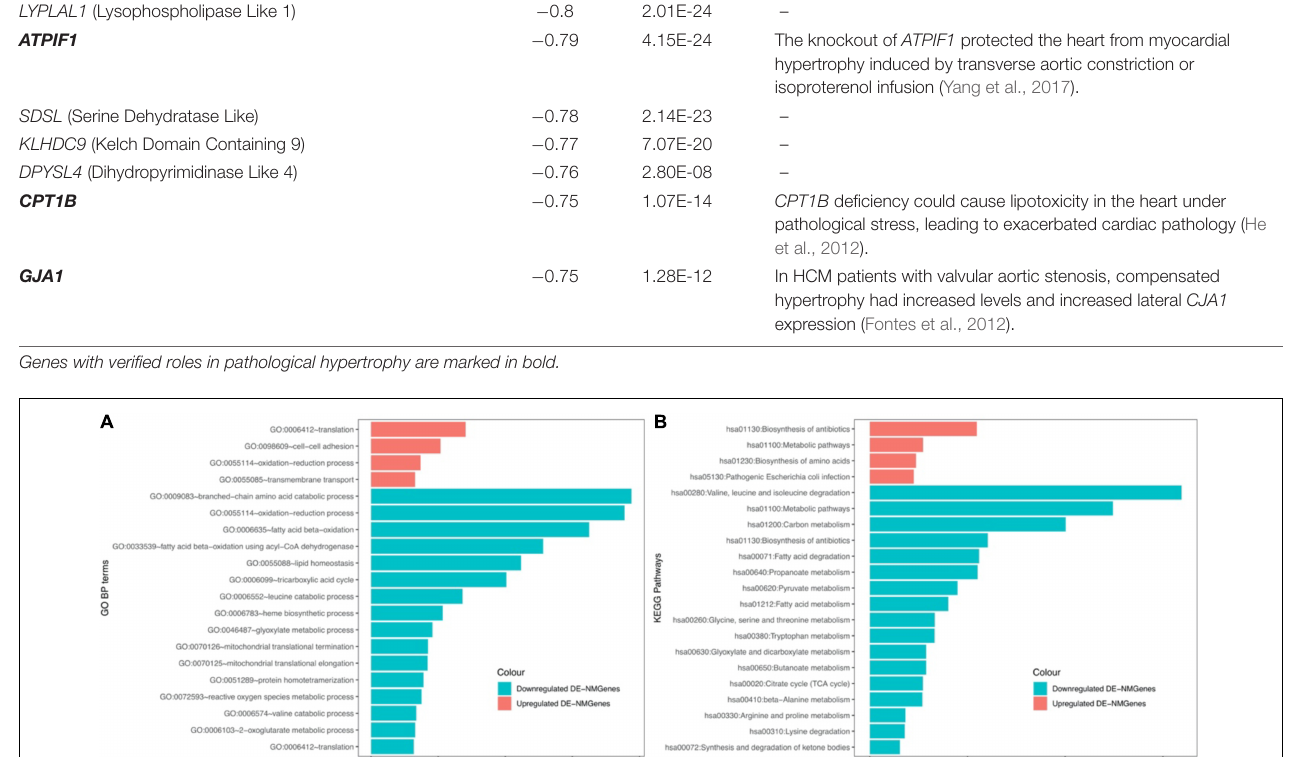
minimum normalized enrichment score > 3 and the FDR